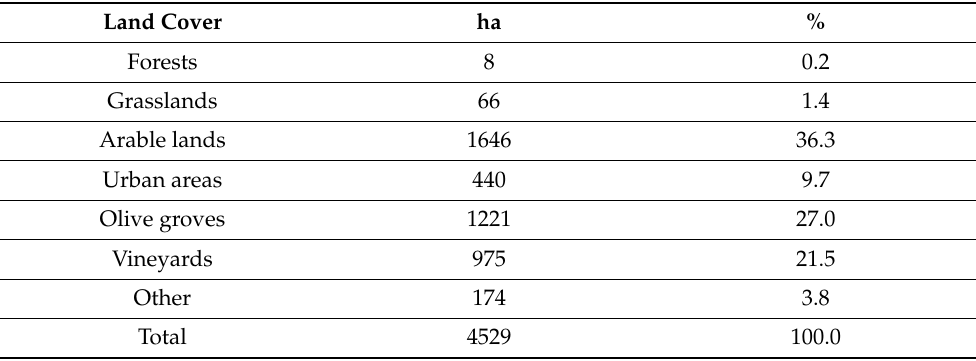
Table 1. Phytosociological analysis of the arboreal vegetation. Species Table 2. Land cover characterisation of the Municipality of Campi [44]. Land Cover ha